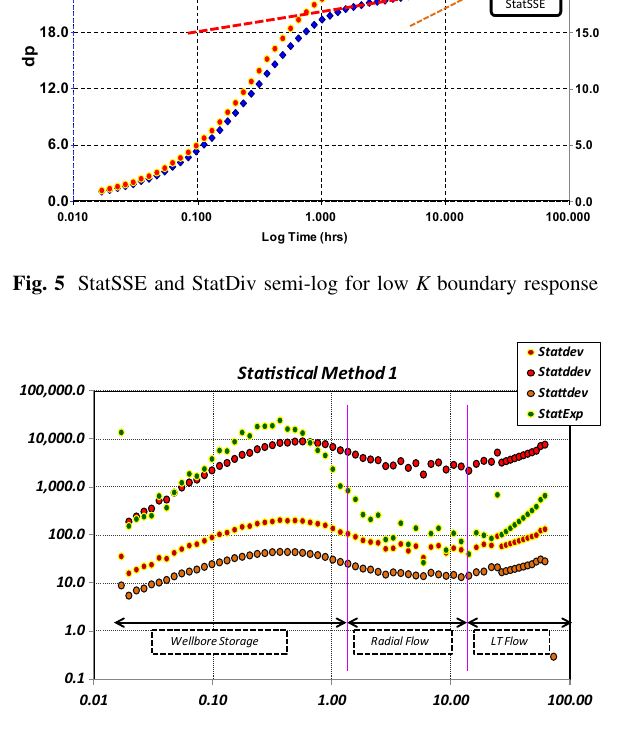
Fig. 6 Comparisons of four statistical diagnostic models for reservoir with boundary conditions